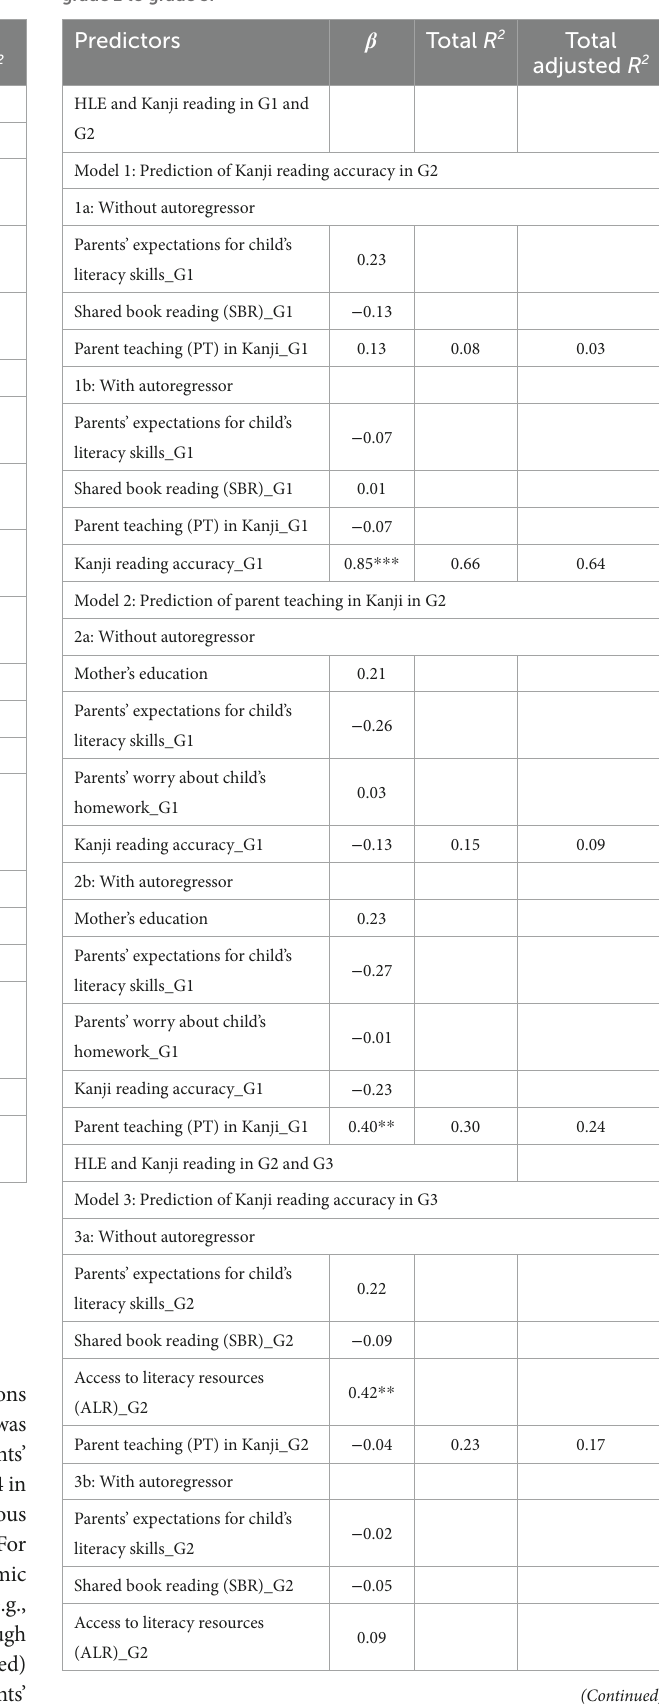
TABLE 5 Multiple regression analyzes for HLE and Kanji reading from grade 1 to grade